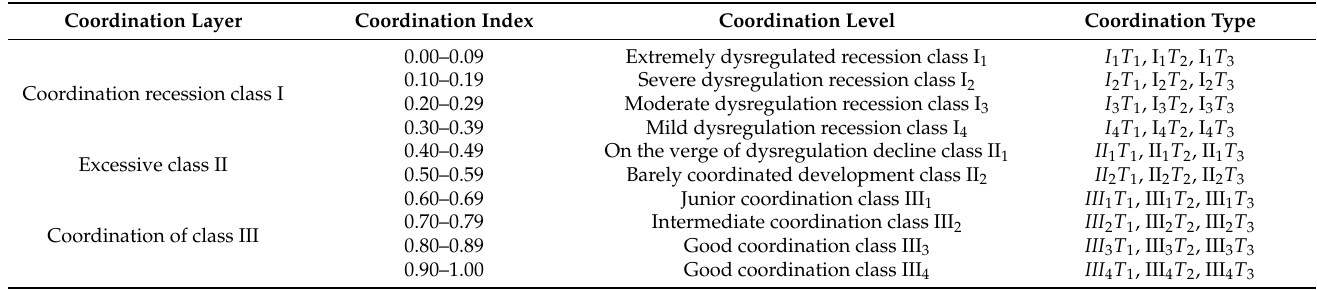
Table 1. Classification standards and types of coupling coordination